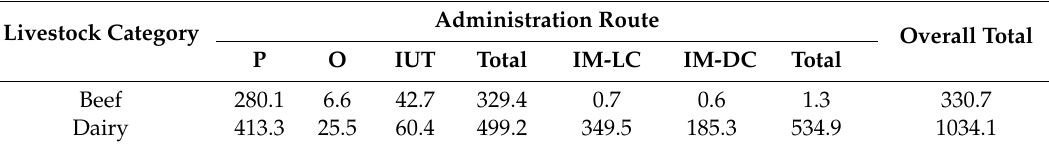
Table A4. Average yearly consumption (DCD vet / year × 10 − 3 ) per individual administration route on beef and dairy farms respectively (P = parenteral, O = oral, IUT = intrauterine, IM-LC = intramammary lactating cow, IM-DC = intramammary dry cow).